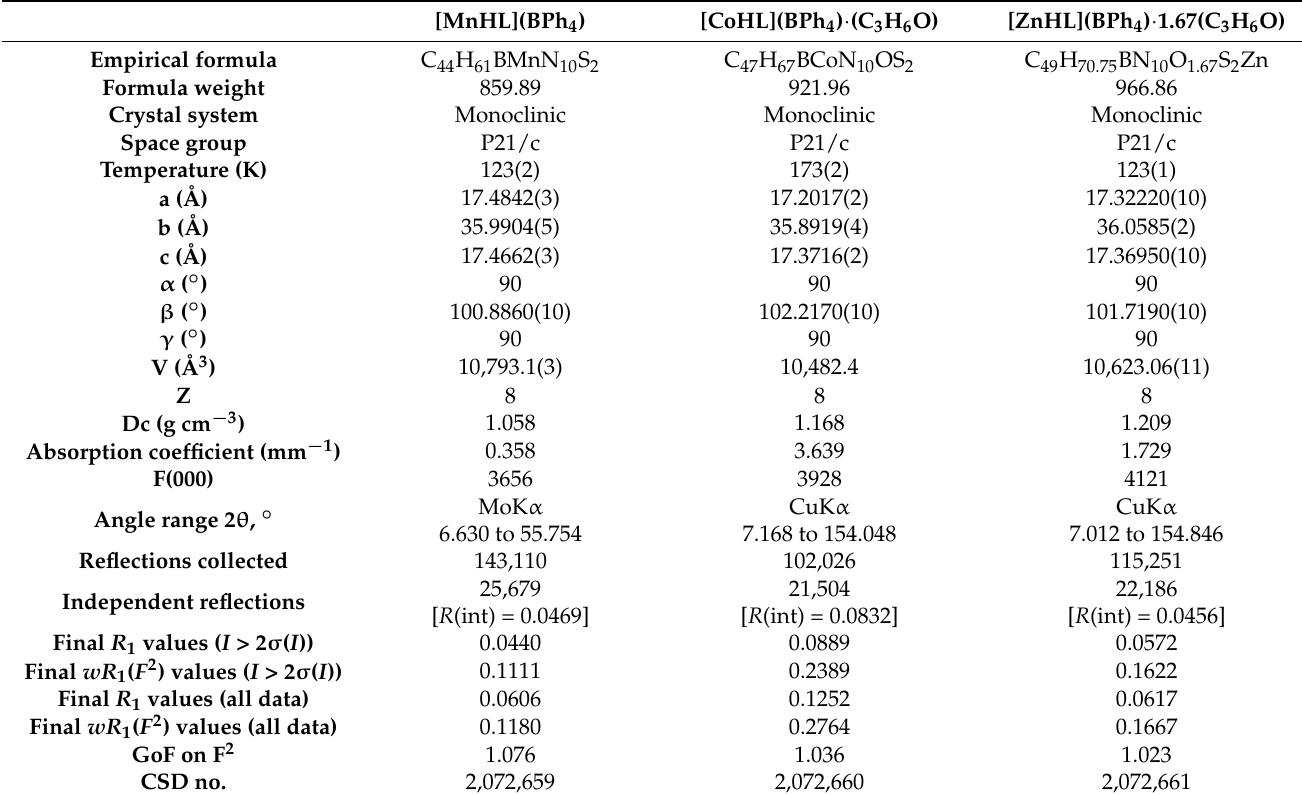
Table 1. Experimental, crystallographic and refinement data for [MnH L ](BPh 4 ), [CoH L ](BPh 4 ) · (C 3 H 6 O) and